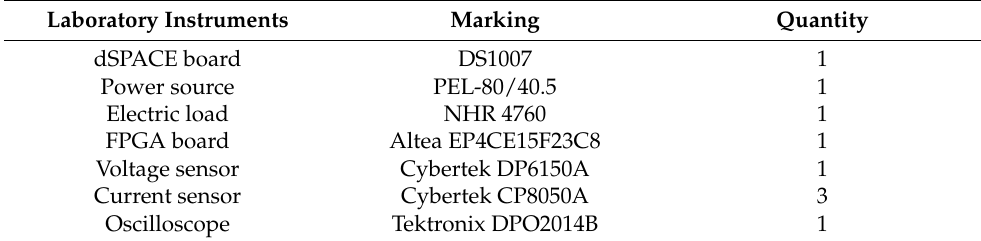
Table 2. Detailed instruments in the experiment.